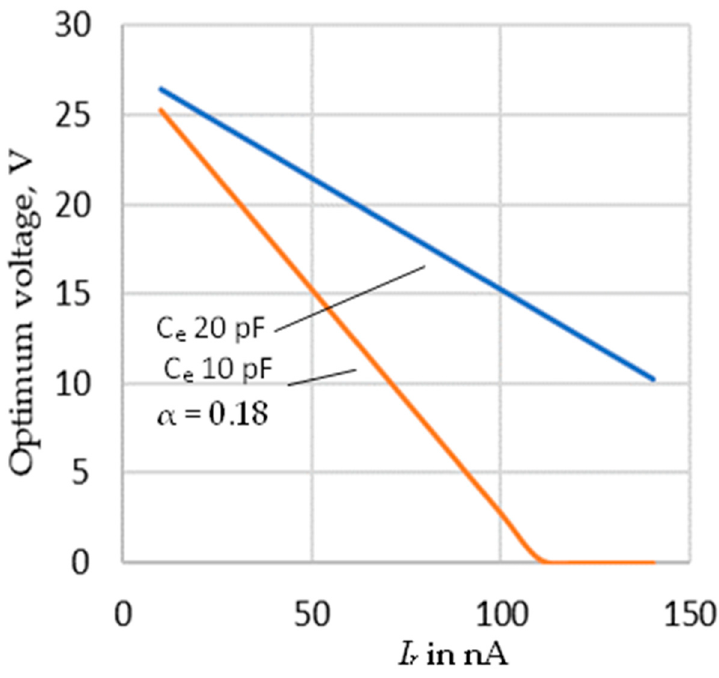
Figure 7. Variation of Optimum voltage for the variation of I r .